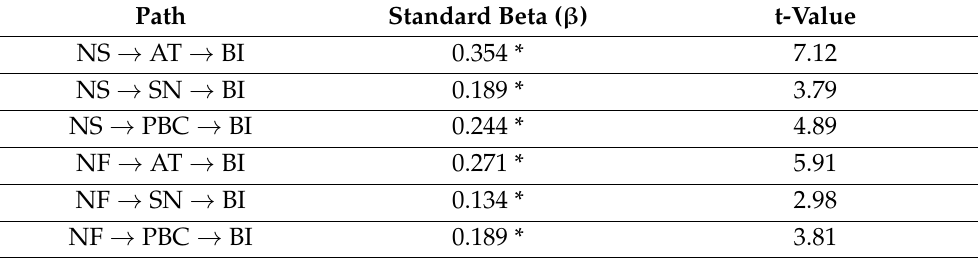
Table 4. Indirect